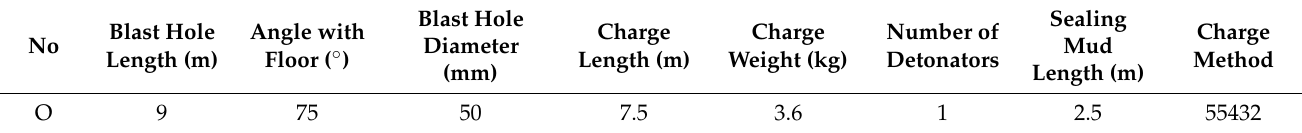
Table 1. Pre-splitting blasting parameters (Zone I).